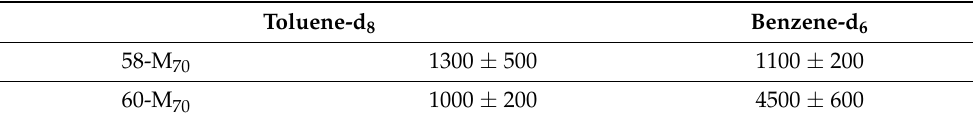
Table 5. Stability constants, K a [M − 1 ], of the 58 - C 70 and 60-C 70 complexes ( 1 H-NMR, 25 ◦ C, 300 MHz)